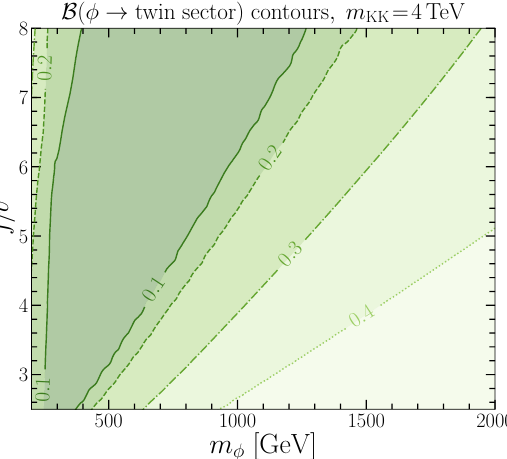
Figure 4 . The twin sector (invisible) branching fraction of the dilaton as a function of m